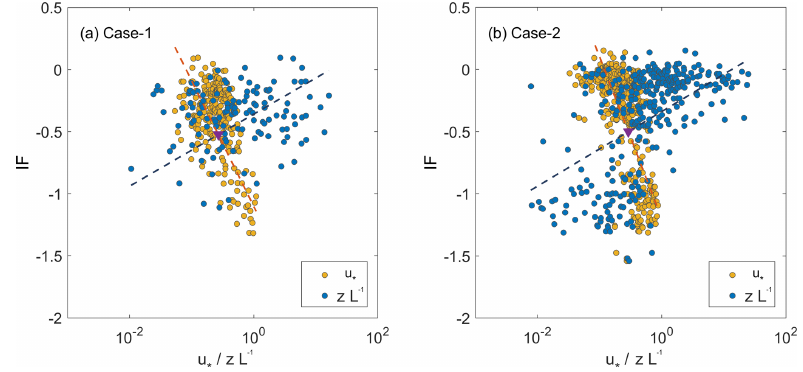
Figure 7. Scatterplot of IF vs. u ∗ and z/L (nighttime) for (a) Case-1 and (b) Case-2 at 40m. The dashed lines are the fittings from least- squares regression, and the triangle marks the cross point.